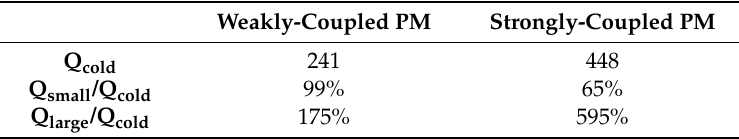
Figure 4. The mode intensity profiles of the ( a ) weakly-coupled mode and ( b ) strongly-coupled mode in the 6-fold symmetric seven-rod photonic molecules (PM). The optical gain parameter setting of rods in a ( c ) cold cavity, ( d ) small spot, and ( e ) large spot scenario. ( f ) An illustration of the influence of rod-to-rod coupling on the overall high-quality factors (Q-factor). The pink circle represents the excitation area. Table 1. The Q-factors of PM modes under different parameter settings.